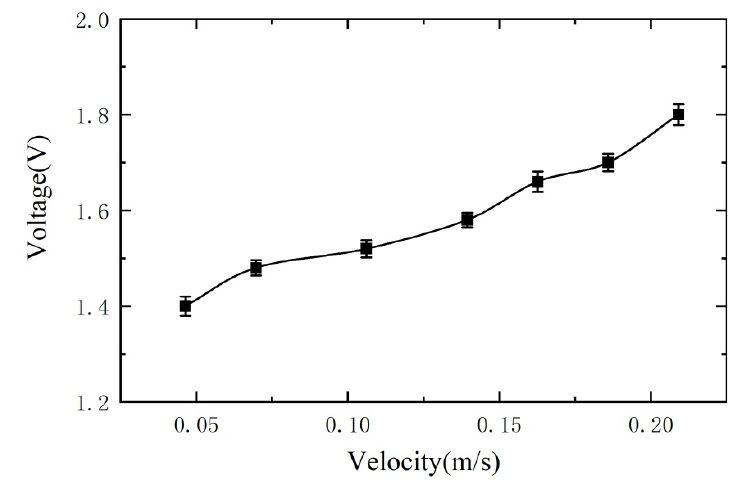
Figure 14. Variation of output voltage with the speed of metal debris passing through sensor.